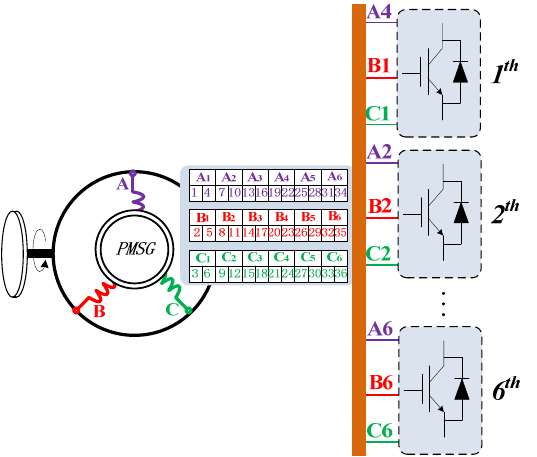
Figure 3. Connection diagram of the voltage source inverters of the 6*3-phase PMSM.